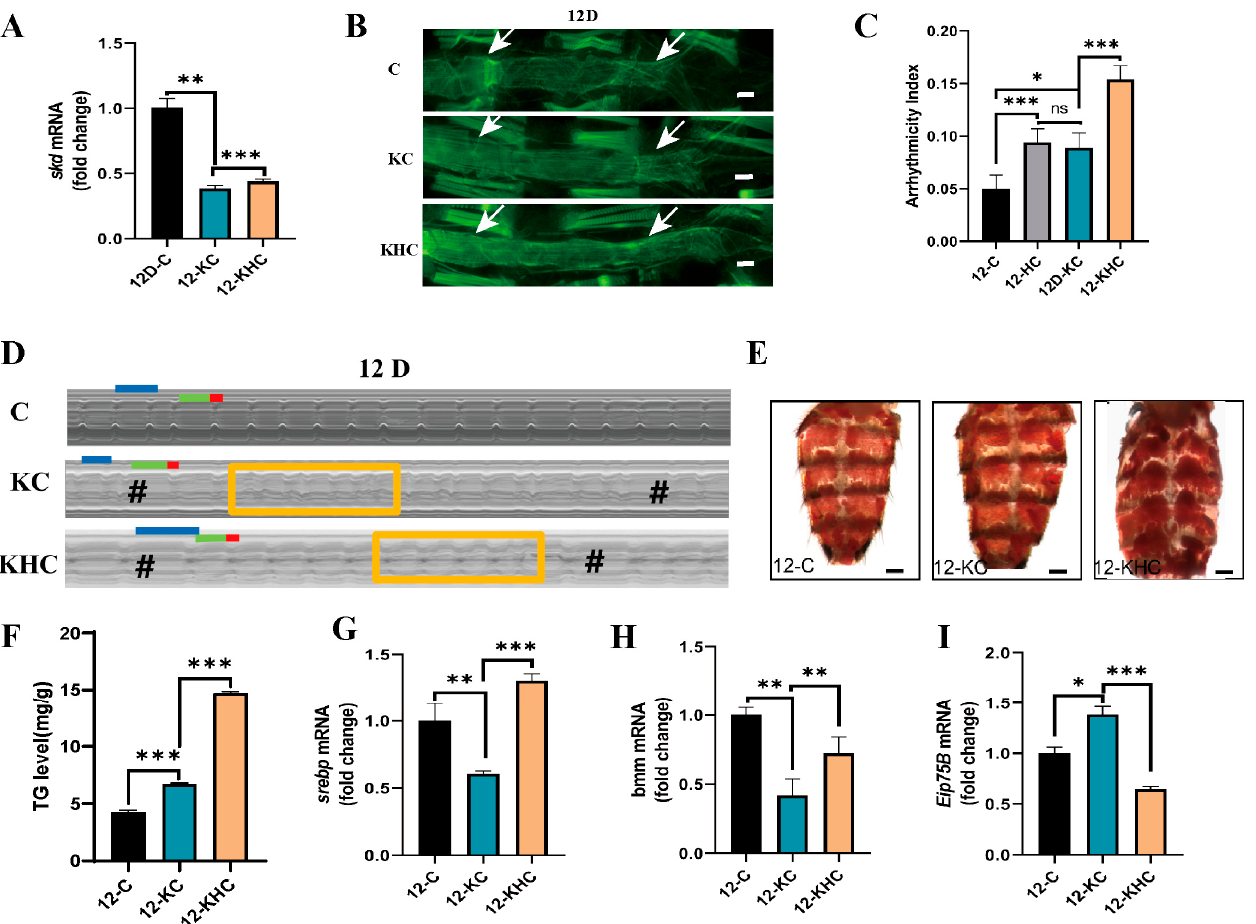
Figure 2. Cardiac function and systemic TG in 12-KC Drosophila under NFD and HFD conditions. ( A ) Cardiac-specific knockdown of skd in Drosophila strain validation and cardiac skd expression under 12-KC HFD conditions. ( B ) Cardiac F-actin staining in 12-KC Drosophila . Note: scale bar = 100 μ m, The two white arrows point to the heart of the fruit fly. ( C ) 12-KC cardiac function under NFD and HFD conditions in Drosophila AI. ( D ) M-mode ECG, cardiac cycle—each group of M-mode ECGs was intercepted for 10 s, N = 25 ± 5. HP: horizontal blue line. DI: horizontal green line. SI: horizontal red line. Rectangle for fibrillation. # for cardiac arrest. ( E ) Drosophila Abdominal ORO. scale bar = 250 μ m, N = 5. ( F ) Drosophila Whole-body TG levels. ( G – I ) The cardiac srebp , bmm, and Eip75B mRNA expression levels on 12D KC Drosophila . Two-factor ANOVA was used, followed by LSD tests for 12-C, 12-HC, 12-KC, and 12-KHC. Independent-samples t test for assessment of 12-C and 12-KC, 12-KC and 12-KHC TG, SREBP, bmm, and Eip75B levels. The data represent the mean, and the error bars represent SEM. ns p > 0.05; * p < 0.05; ** p < 0.01; *** p < 0.001.